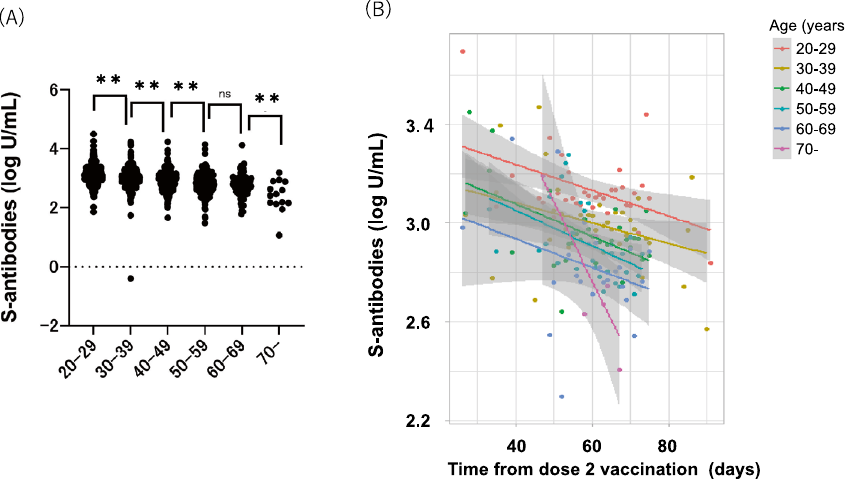
Figure 4. Distribution and reduction of total S-specific antibodies in participants after second vaccination among age group. ( A ) Total S-specific antibody levels were quantified. Statistical analysis was performed with one-way ANOVA among age 20–29 (n = 724), 30–39 (n = 673), 40–49 (n = 471), 50–59 (n = 229), 60–69 (n = 91), and 70 + (n = 14). **p value < 0.001. ( B ) Scatterplot and regression line colors indicate antibody response for the age groups mentioned in ( A ). The 95% CIs are calculated by prediction ± 1.96 × standard error of prediction. ns, no significant difference.